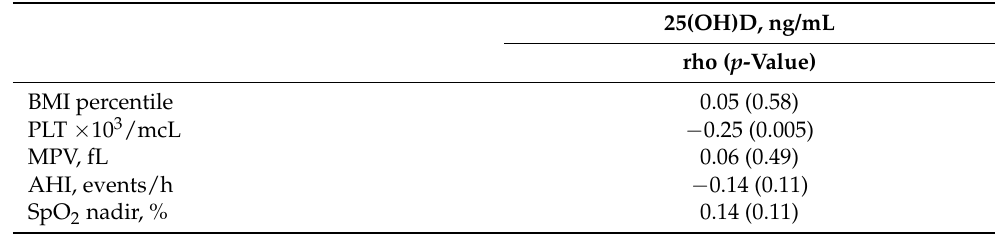
Table 4. Correlations between serum 25(OH)D levels and Body Mass Index percentile, platelet count, Mean Platelet Volume, Apnea–Hypopnea Index, SpO 2 nadir in OSAS patients.